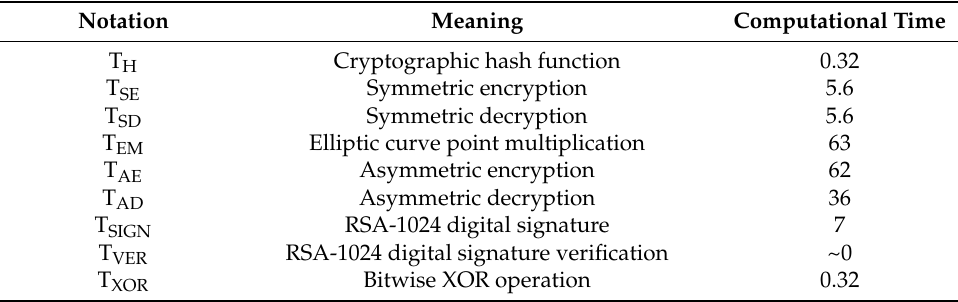
Table 5. Approximate computational time in